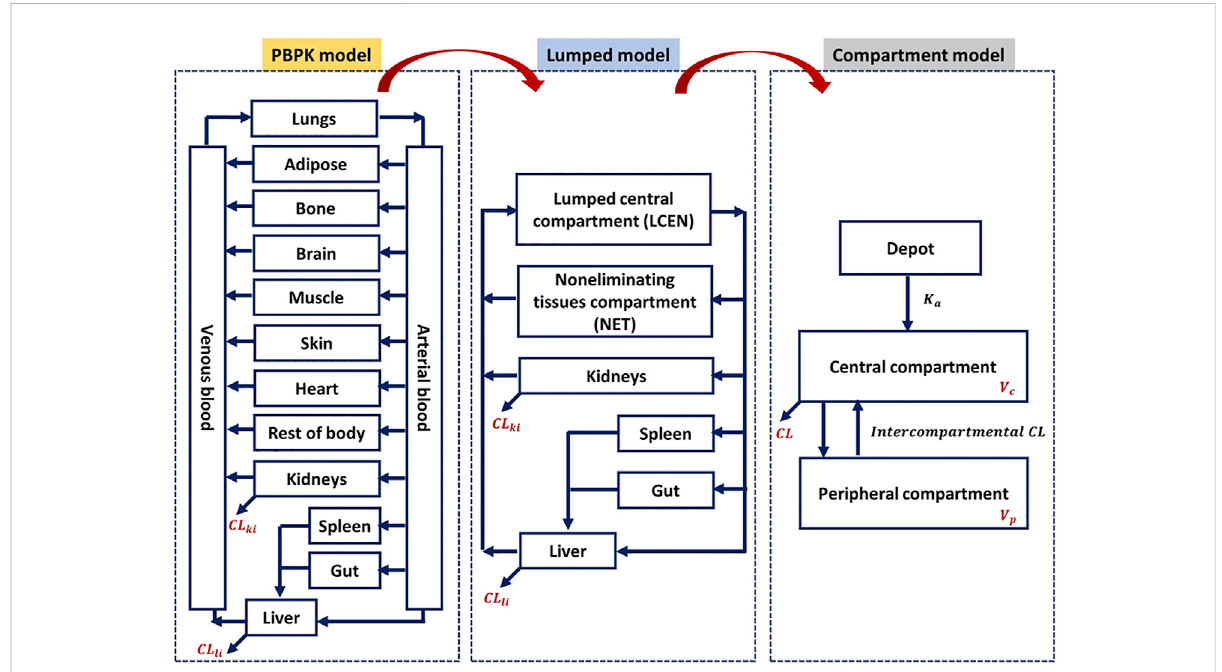
FIGURE 1 Schematic compatibility relationships among PBPK, lumped, and compartment